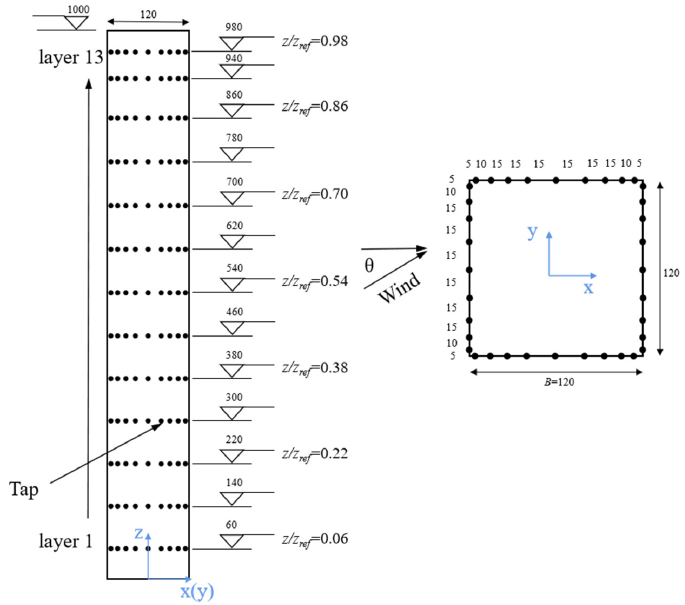
Figure 3. Distribution of pressure taps on model facades (unit: mm).